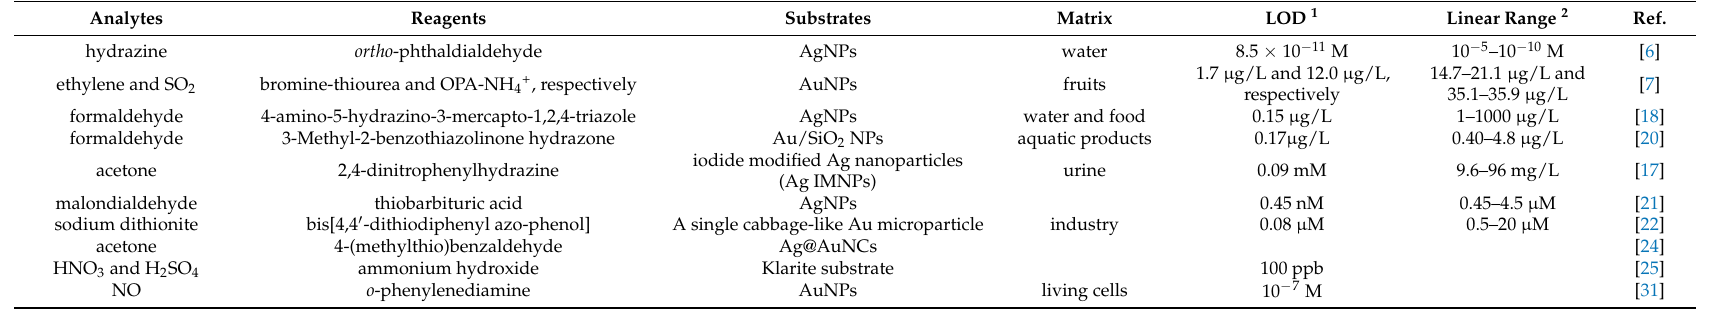
Table 1. Representative studies of reaction-SERS